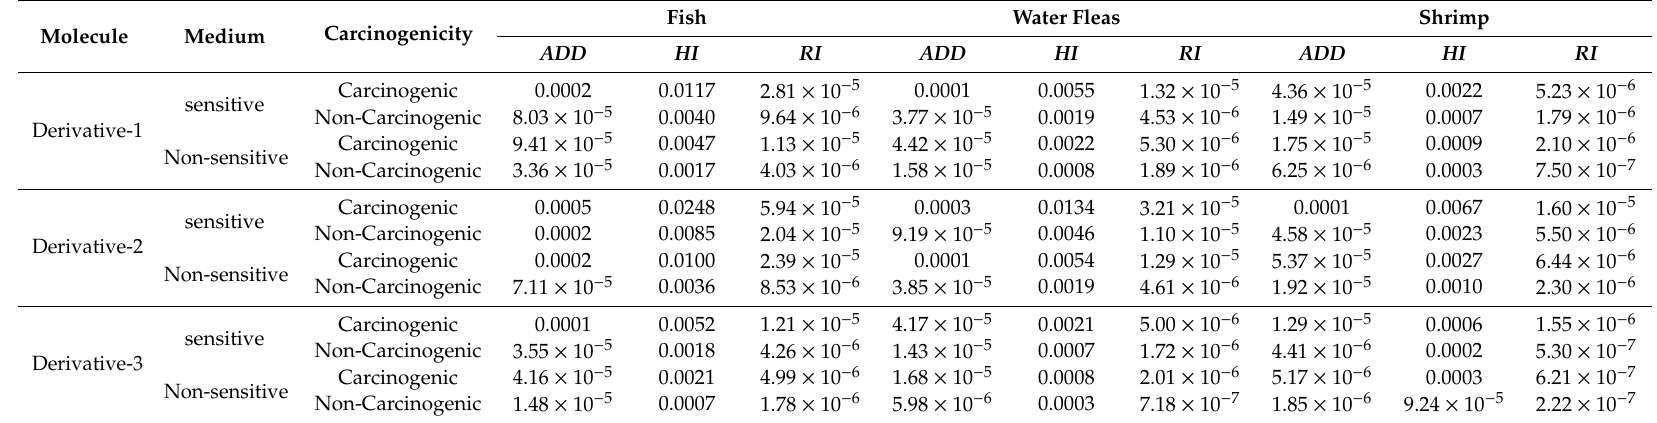
Table 8. Exposure dose (ADD) , Non-carcinogenic risk index (HI) , and Lifetime cancer risk index (RI) evaluation results of three PAZ